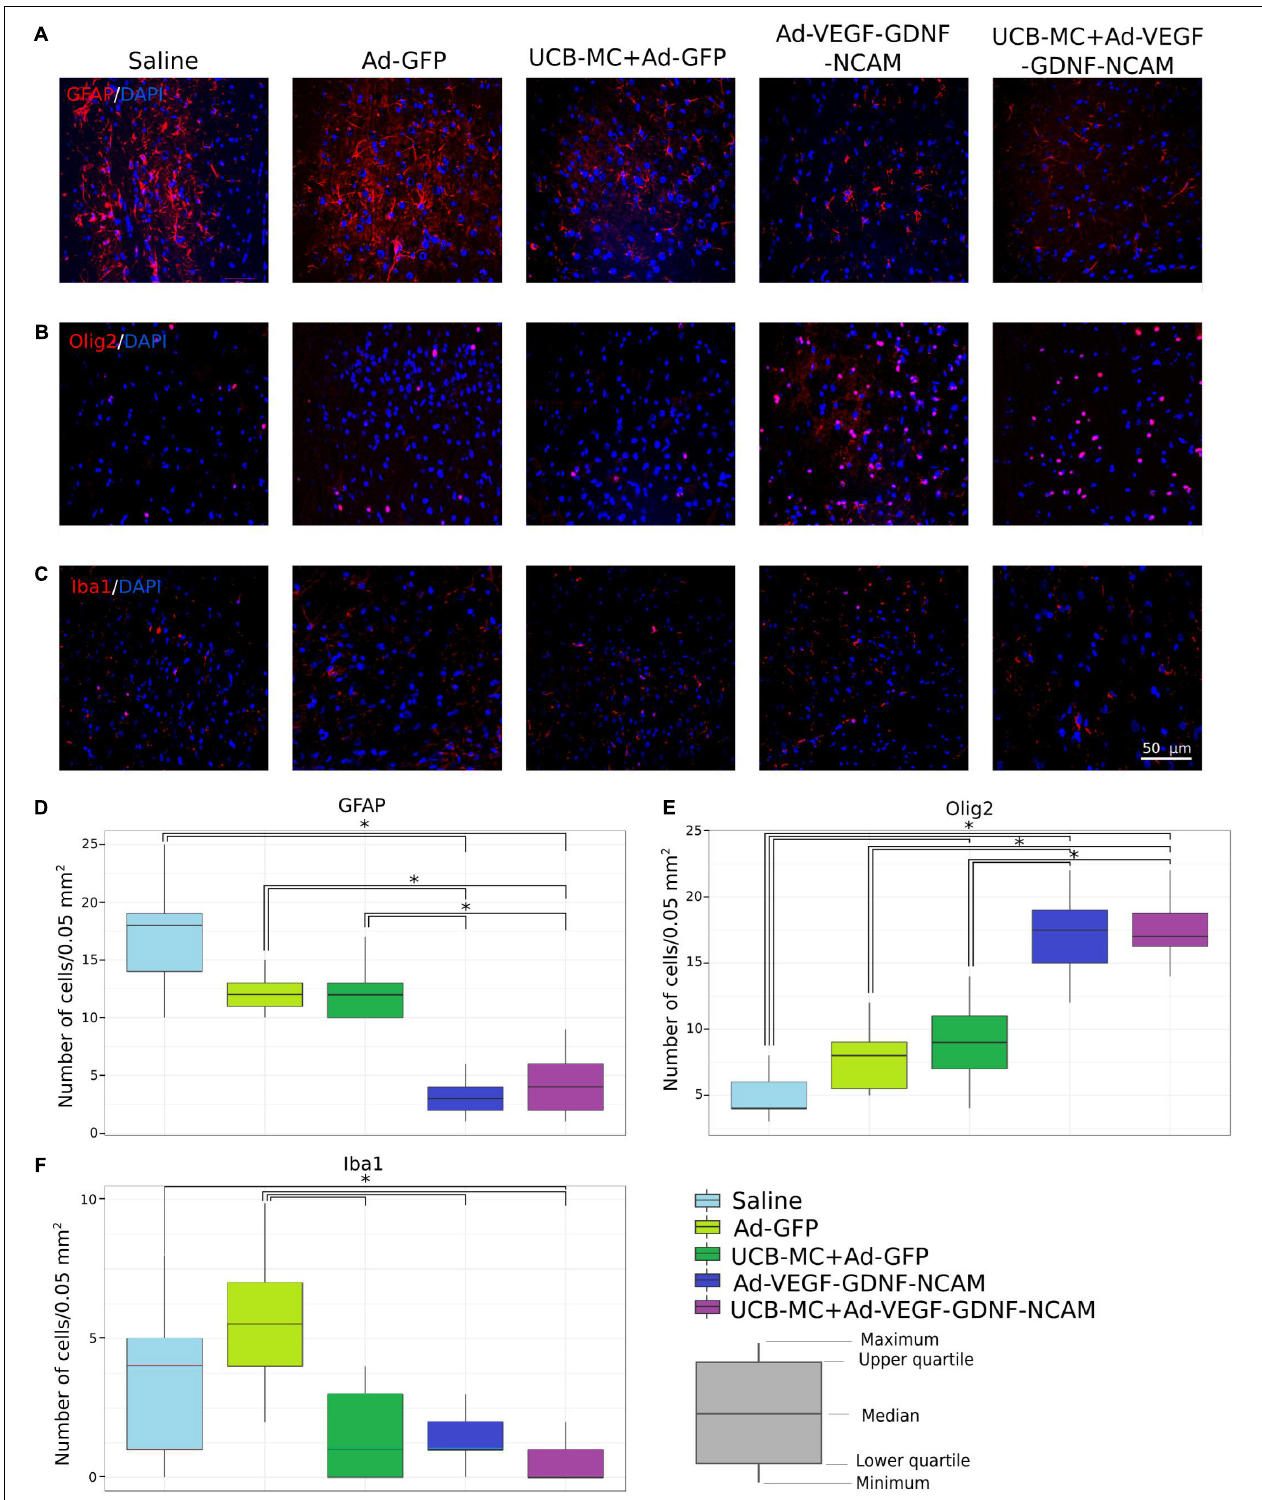
FIGURE 4 | Reaction of glial cells in brain cortex on triple gene therapy 21 days after the distal permanent occlusion of the MCA. (A–C) Immunofluorescent staining of astrocytes with Abs against GFAP (A) , oligodendroglial cells with Abs against Olig2 (B) , and microglial cells with Abs against Iba1 (C) . Nuclei (blue) were counterstained with DAPI. Scale bar = 50 µ m. (D–F) Number of GFAP immunopositive cells (D) , number of Olig2 immunopositive cells (E) , and number of Iba1 immunopositive cells (F) . Data are visualized using box plots. ∗ Difference between experimental groups, p < 0.05.